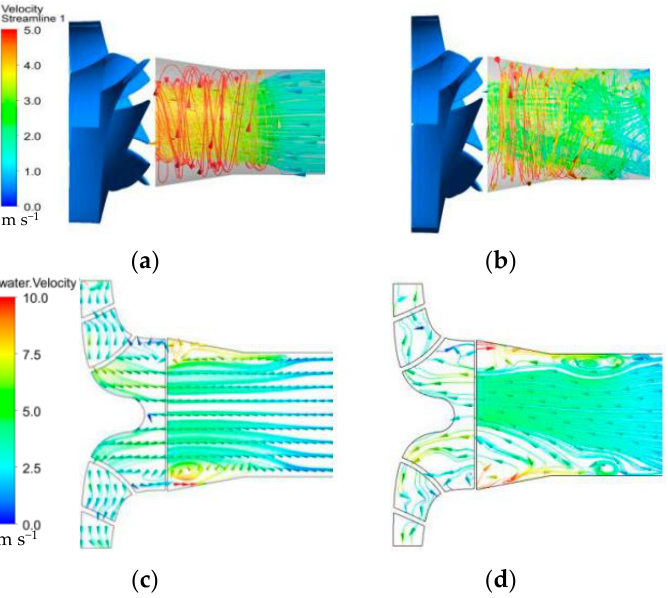
Figure 11. Gas–liquid multiphase patterns within impeller flow channel at designed rotational speed [29], 𝜑 = 0.038 : ( a ) IAVF = 0%; ( b ) IAVF = 7%; ( c ) IAVF = 0%; ( d ) IAVF = 7%.